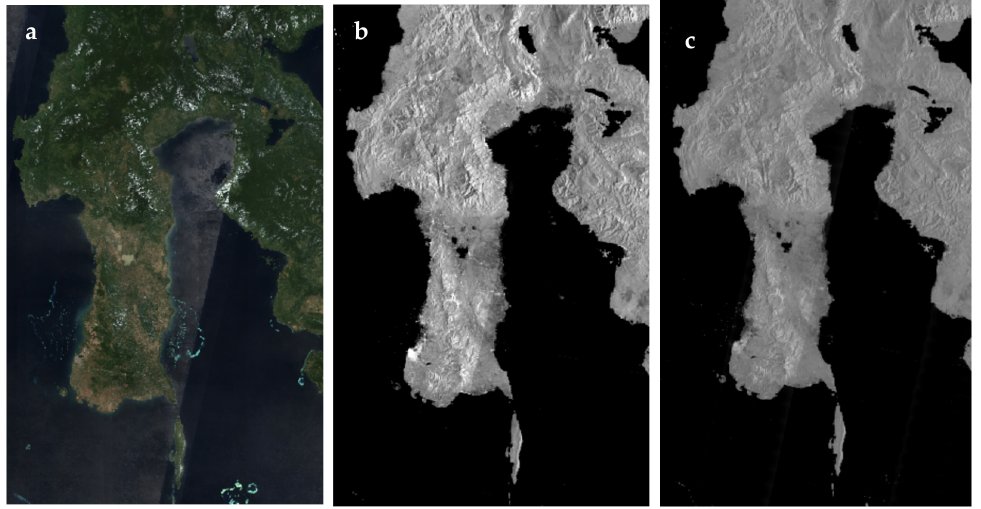
Figure 2. Sentinel 2 Multispectral True Colour ( a ), Sentinel 1 Polarisation VV ( b ) and VH ( c ) in Sulawesi Selatan Province.